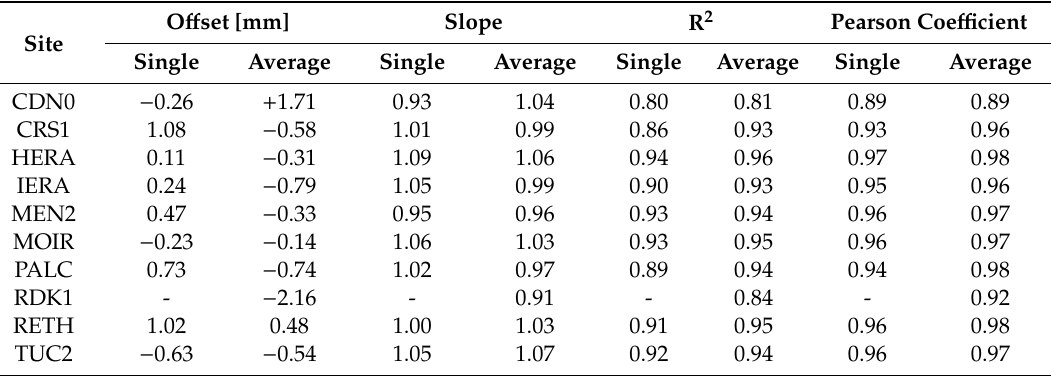
Table 3. The mean and standard deviation (SD) for the IWV values derived from Sentinel-3A OLCI using the “single point” (IWV sgl ) and the “area-of-influence” (IWV avg ) approaches, and from the GNSS, as well as for their differences at each GNSS station. All values are in [mm]. The overall mean Table 4. Statistical analysis of the correlation between the Sentinel-3A OLCI and GNSS IWV values at and SD per IWV determination are given in the GNSS stations over the study area. The confidence level for regression analysis is 95% and in all cases the Pearson p -value (probability) is < 0.003.